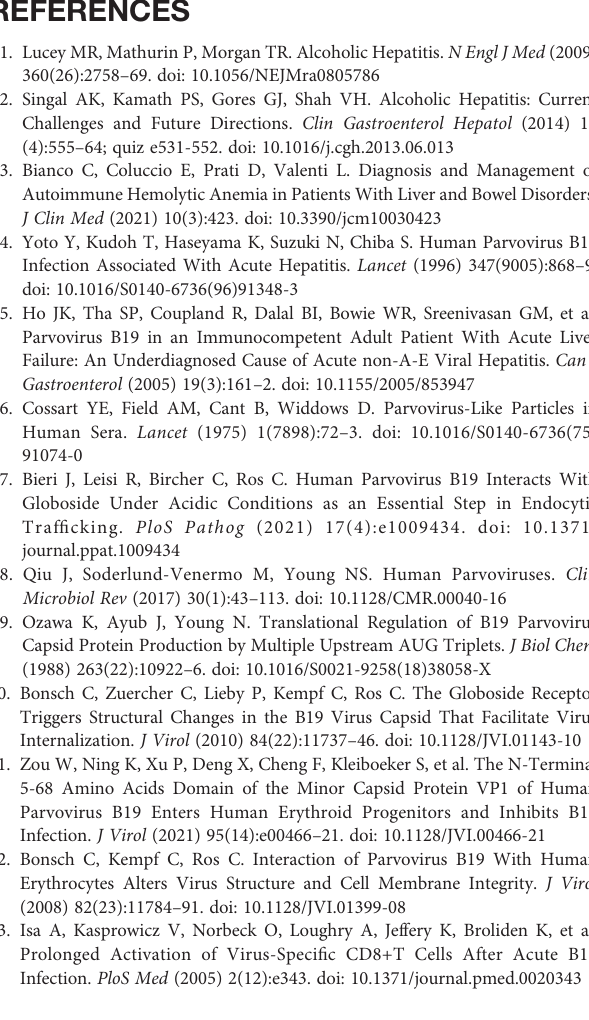
Supplementary Table 1 | Part of the results of the patient ’ s blood routine, biochemical, infection and in fl ammation related tests during the course of the disease, as well as the daily urine output and blood transfusion volume. WBC, white blood cell. RBC, red blood cell. Hb, hemoglobin. MCV, mean corpuscular volume. PLT, Platelet. Ret, reticulocytes. AST, aspartate aminotransferase. ALT, alanine aminotransferase. TBIL, total bilirubin. DBIL, direct bilirubin. IBIL, indirect bilirubin. Cr, creatinine. PTA, prothrombin activity. INR, international normalized ratio. FIB, fi brinogen. CRP, C-reactive protein. PCT, procalcitonin. IL-6,